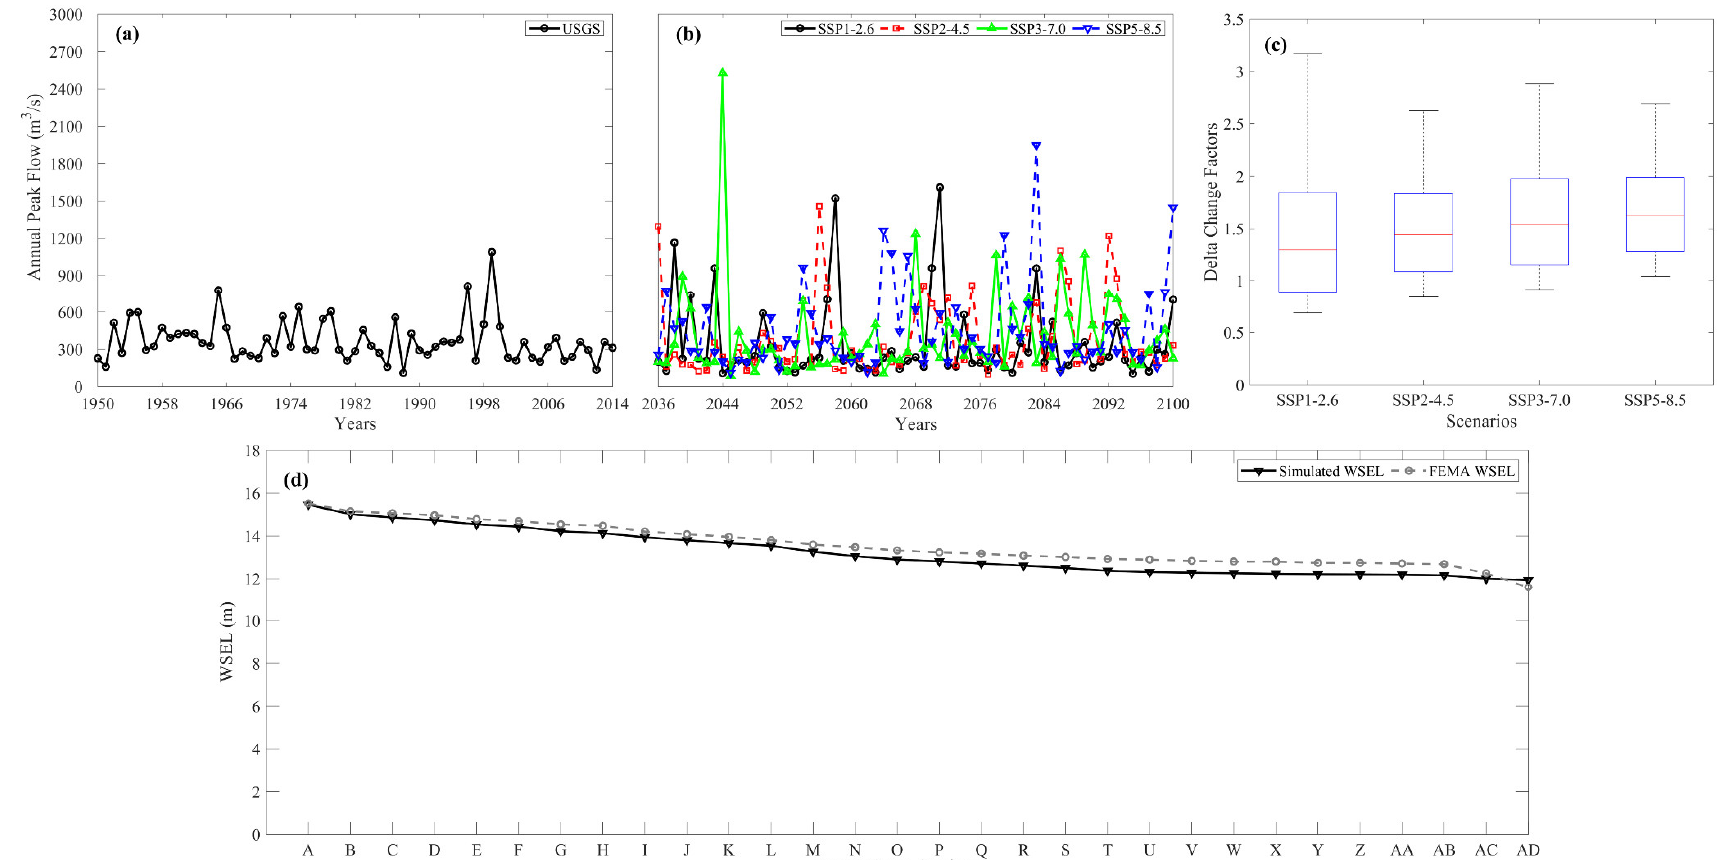
Figure 5. Annual peak streamflow for ( a ) historical and ( b ) future scenarios; ( c ) Box plot for the comparison of different future scenarios DCF using different recurrence intervals; ( d ) Calibration plot of FFR given WSEL versus Simulated WSEL.